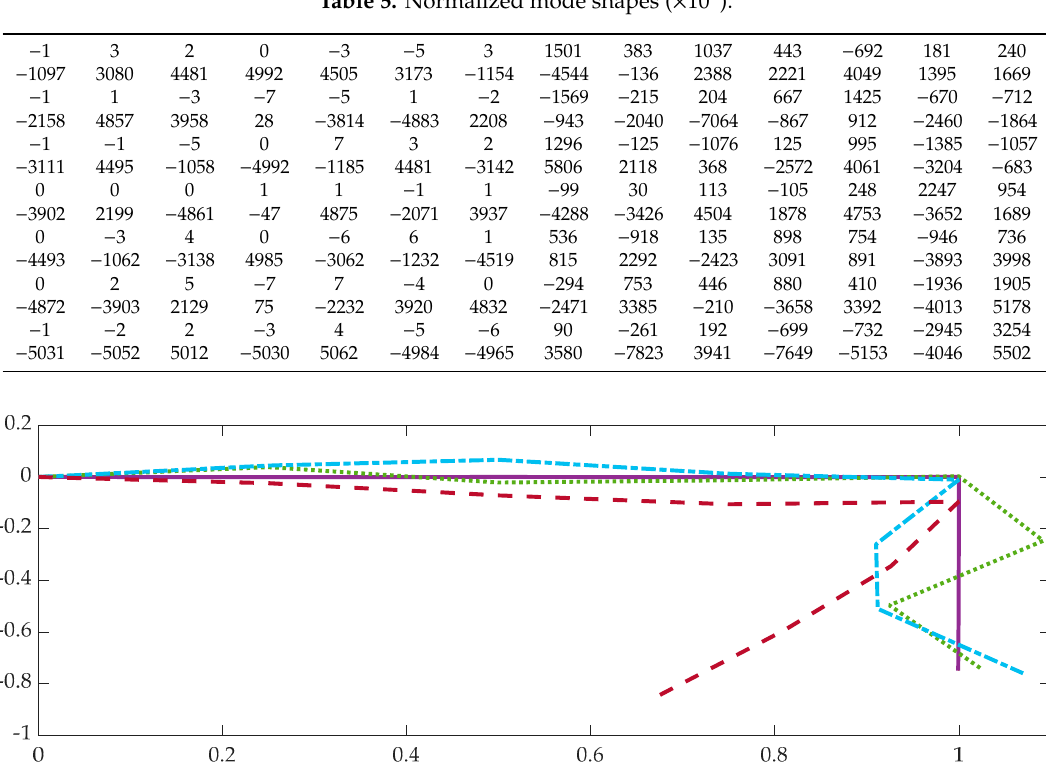
Table 4. Natural frequencies, 𝜔 (cid:3041) (rad/s) 1 .